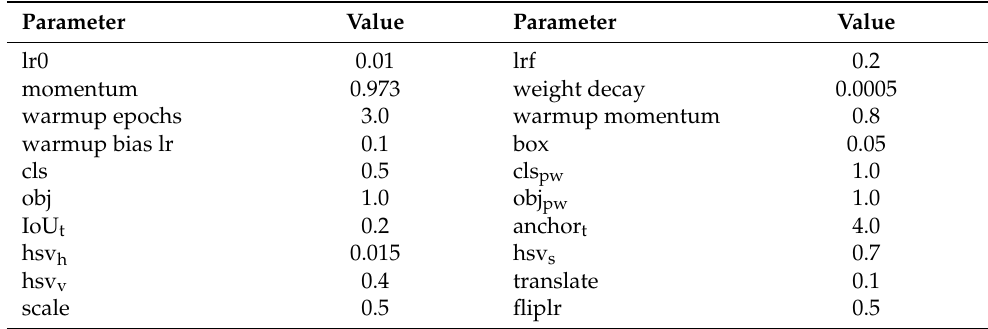
Table 3. YOLO training options and parameters